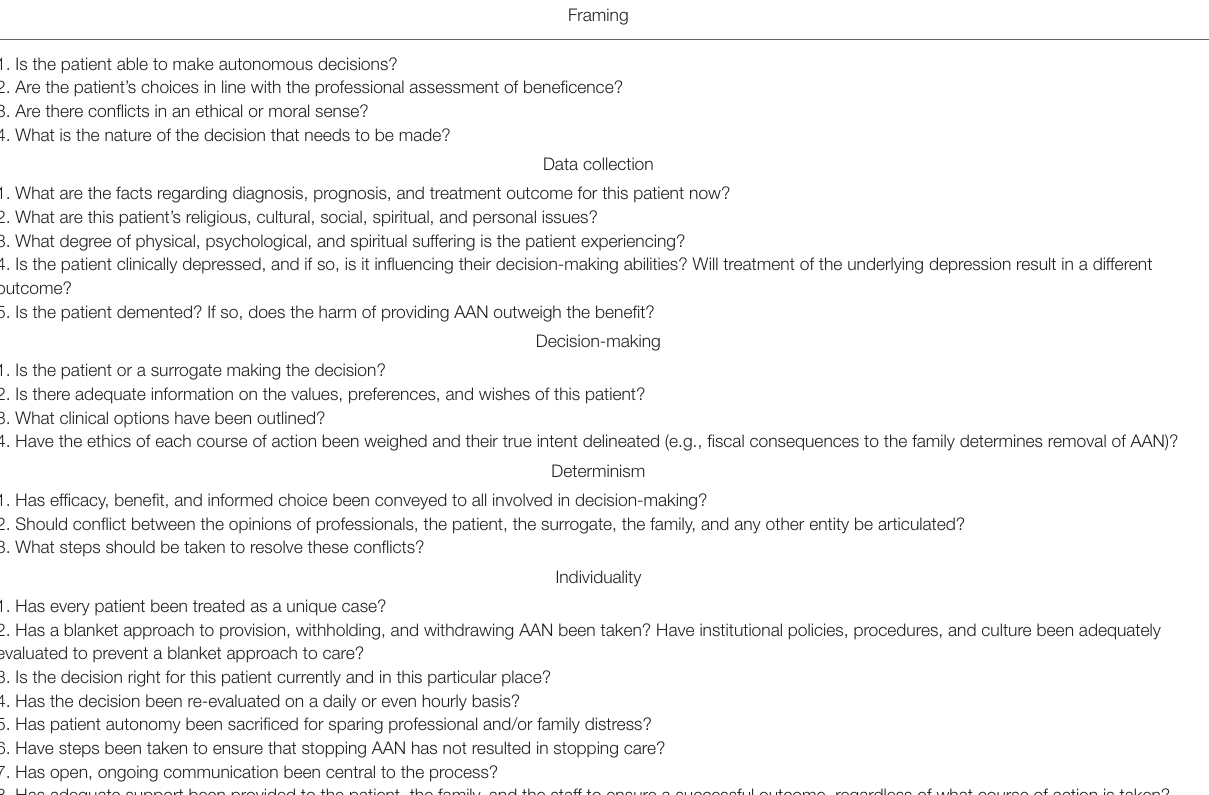
TABLE 1 | Questions to ask regarding the ethics of providing AAN